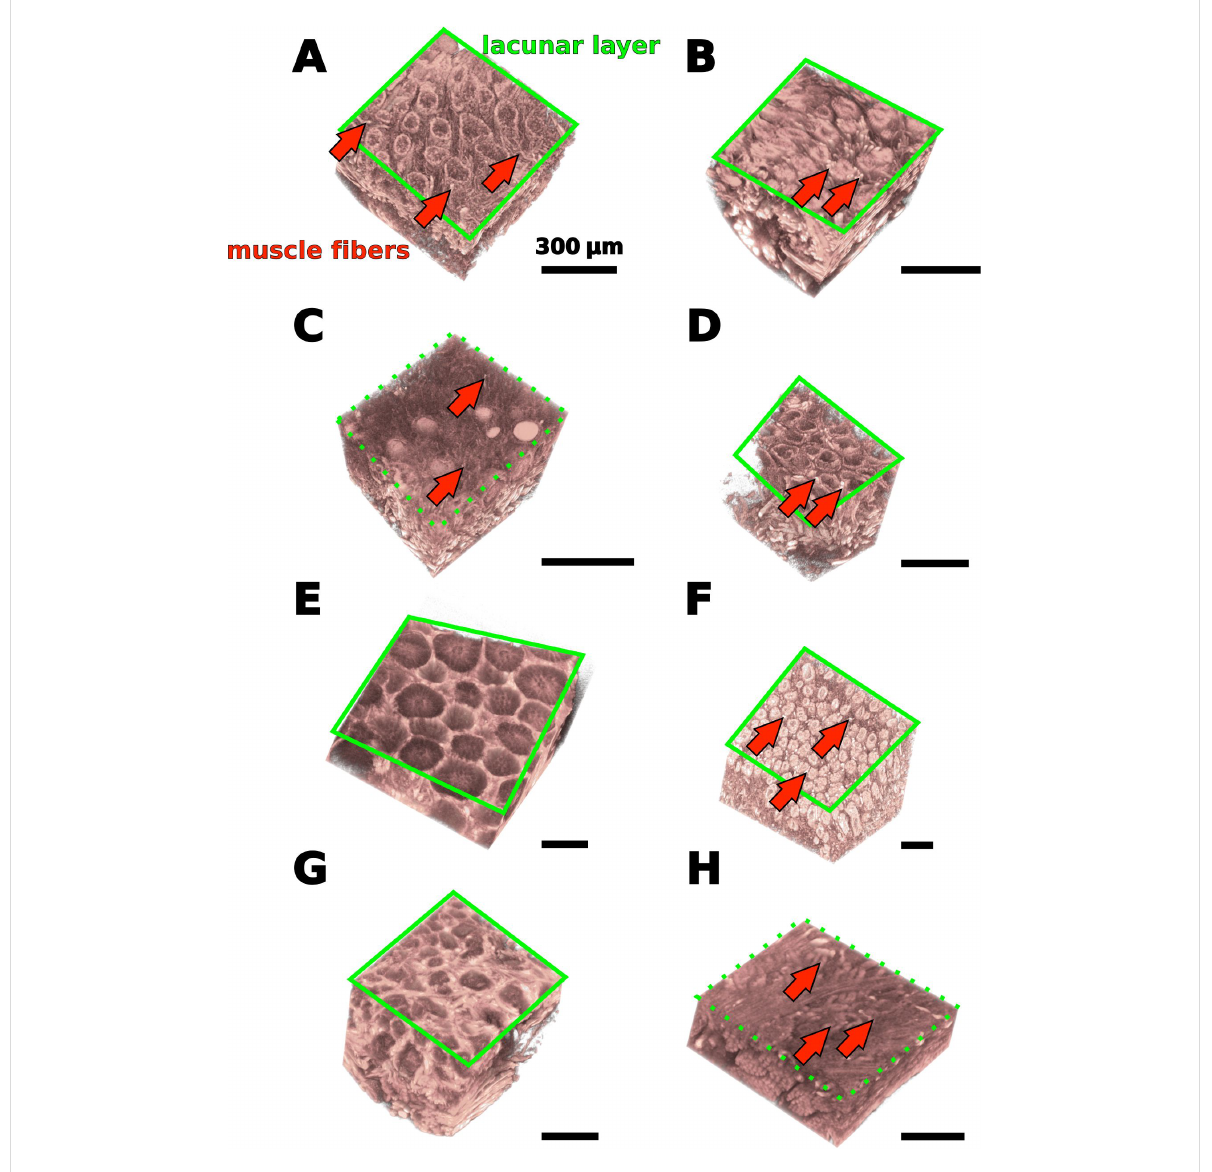
Figure 4: Virtual section through the micro-CT data of tongue tissue fragments at the level of the lacunar layer. A – Bombina variegata , B – Discoglossus pictus , C – Ceratophrys ornata , D – Litoria caerulea , E – Megophrys nasuta , F – Rana ( Lithobates ) pipiens , G – Bufo bufo , H – Oophaga histrionica . In B. variegata (A), D. pictus (B), and L. infrafrenata (D), the lacunae seem to be more similar than in the remainder species. In C. ornata (C) and O. histrionica (H), we were not able to find lacunae by using micro-CT imaging. Full slice movies of the micro-CT data are avail- able in Supporting Information File 1. Muscle fibers (red arrows) emerge between the lacunae and face towards the tongue